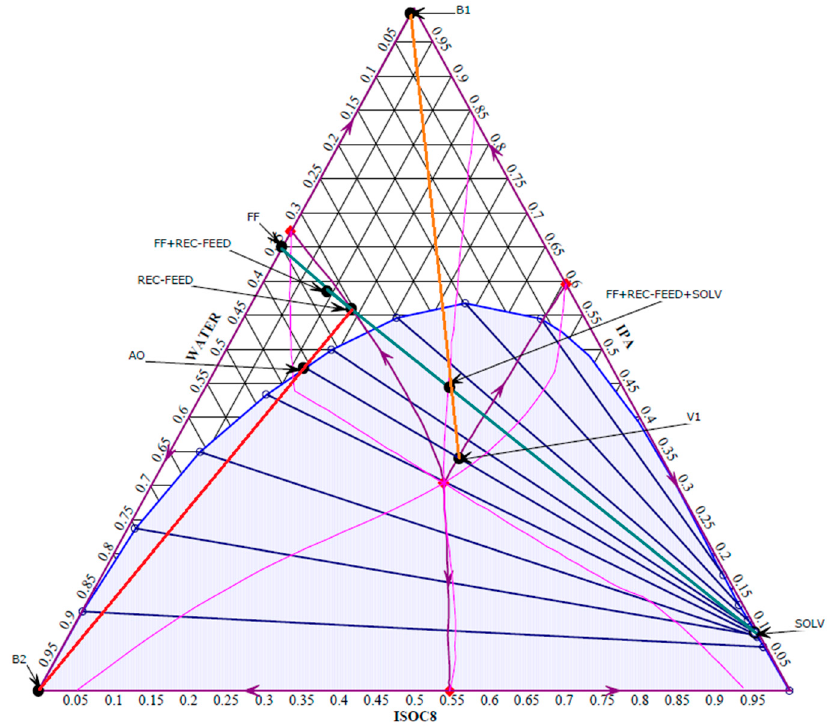
Figure 11. Ternary map at 1 atm for the system 2-propanol (IPA) + water (WATER) + isooctane (ISOC8), showing the points corresponding to the streams involved in the process illustrated in Figure 10, the material balance line for the HAD column (in orange), and the material balance line for the recovery column (in red).